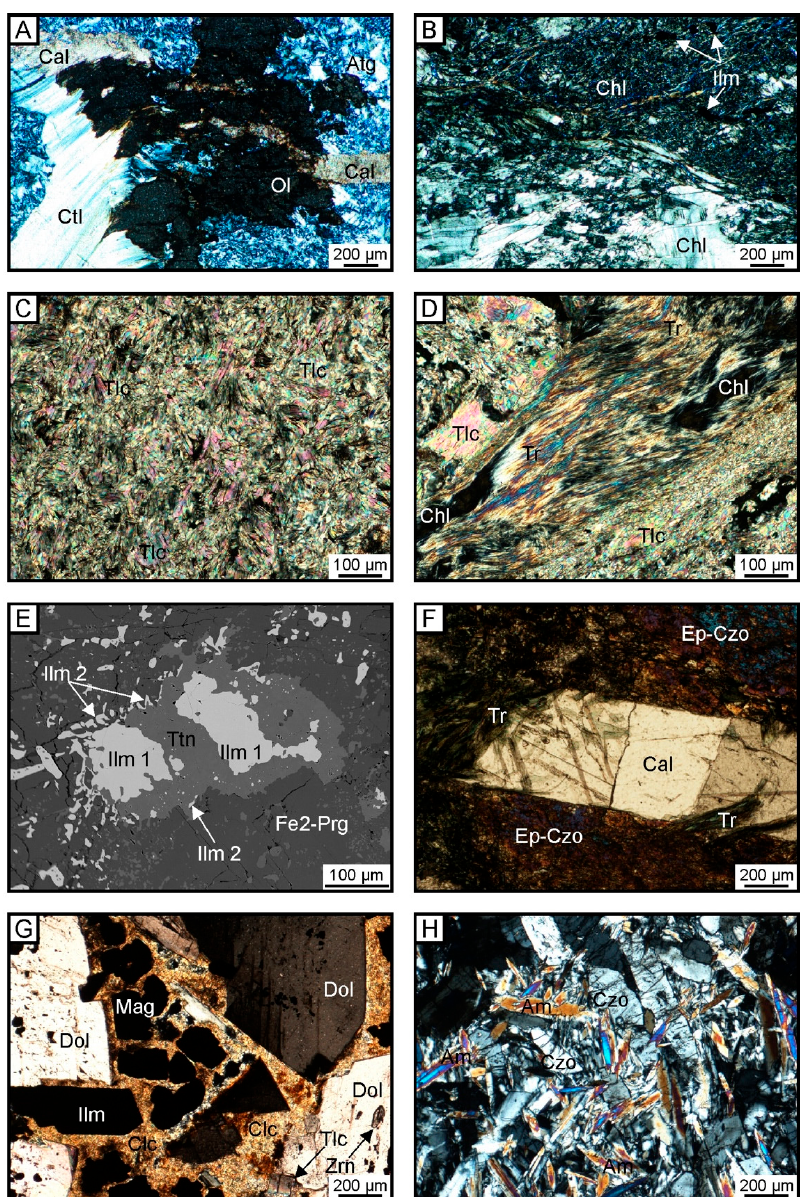
Figure 6. Microphotographs ( A – D , F – H ) and BSE image ( E ) of the studied samples. ( A ) An antigorite serpentinite cut by chrysotile and calcite veins, at which margins crystallized an olivine related with deserpentinization; ( B ) Fine- and coarse-grained zones in the chlorite schist KL-5; ( C ) A medium-grained groundmass of the talc schist KL-13; ( D ) A fibrous tremolite vein (probably a shear zone relic) cutting the talc schist (KL-13); ( E ) BSE image of a relic igneous ilmenite (Ilm 1 = ilmenite 1), partially-replaced by a metamorphic titanite, and then probably also by the secondary metamorphic ilmenite (Ilm 2 = ilmenite 2), hosted in hornblendite KL-1; ( F ) A calcite vein cutting the epidote-clinozoisite groundmass, which are then partially-replaced by tremolite needles (epidote hornblendite KL-11); ( G ) The fine-grained clinochlore filling spaces between the coarse dolomite, as well as fine- to medium-grained magnetite, ilmenite and talc crystals (mineralized dolomite vein KL-3C); note the fine zircon inclusion within the coarse dolomite; ( H ) A barren metagabbro (KL-6) groundmass composed of amphiboles